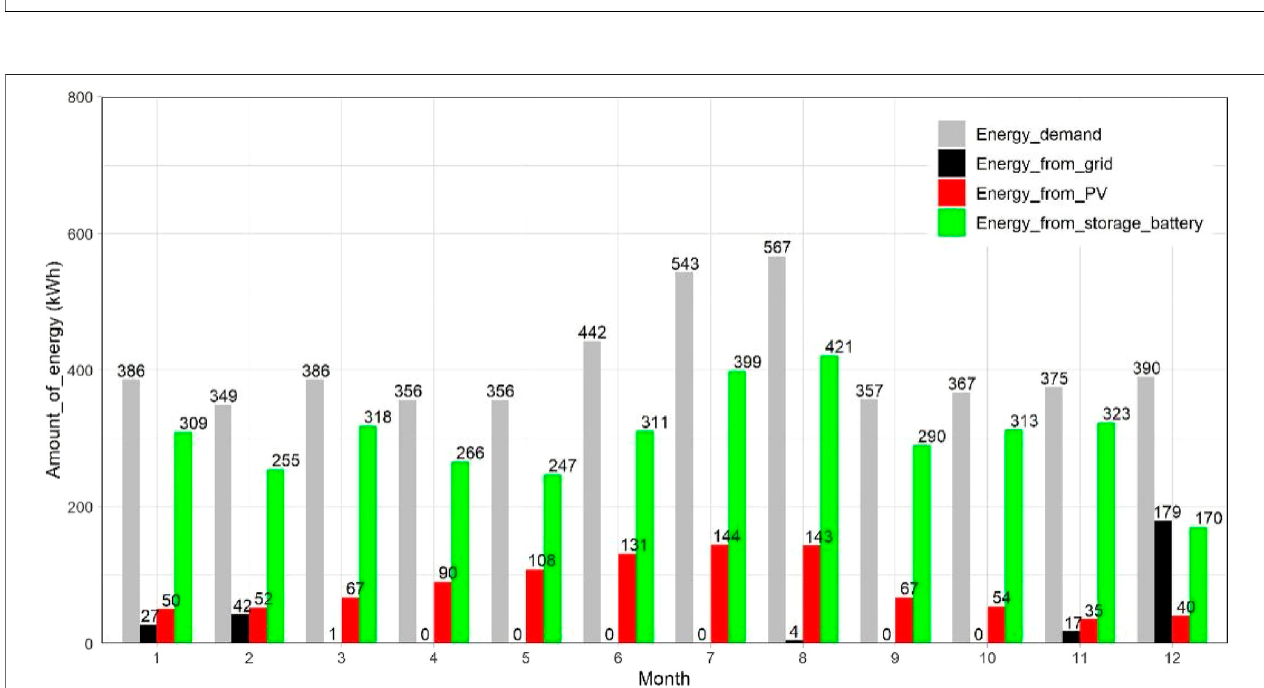
FIGURE 6 | Monthly simulation results using the traditional method of sizing devices (with 62 m 2 area, 26 ° PV installation angle, and 56 kWh energy of the storage battery).